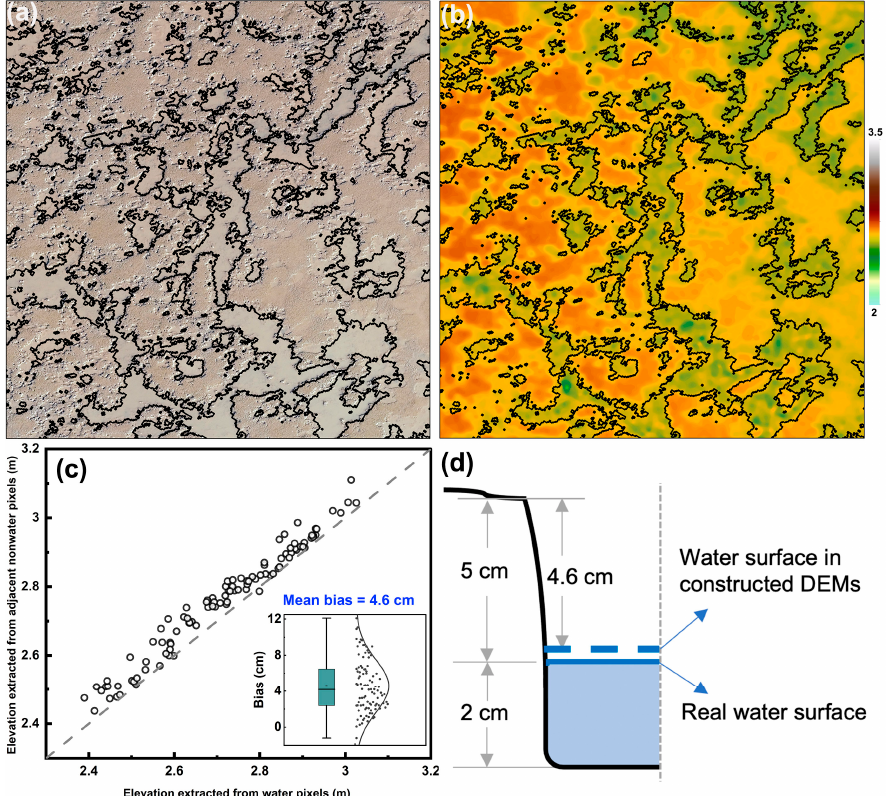
Figure 7. The impact of surface water-bearing layer on UAV-based DEM: ( a ) Water pixel identifica- tion results overlayed on the orthophotos; ( b ) water pixel identification results overlayed on UAV- based DEM; ( c ) comparison between elevations of water pixels and adjacent non-water pixels; and ( d ) the semi-profile schematic of ground elevation overestimation in water areas.